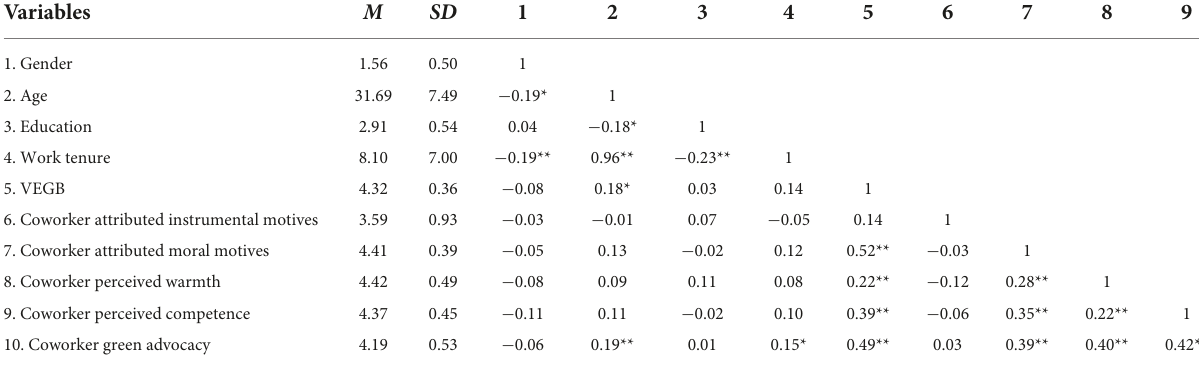
TABLE 2 Descriptive statistics, correlations, and square roots of